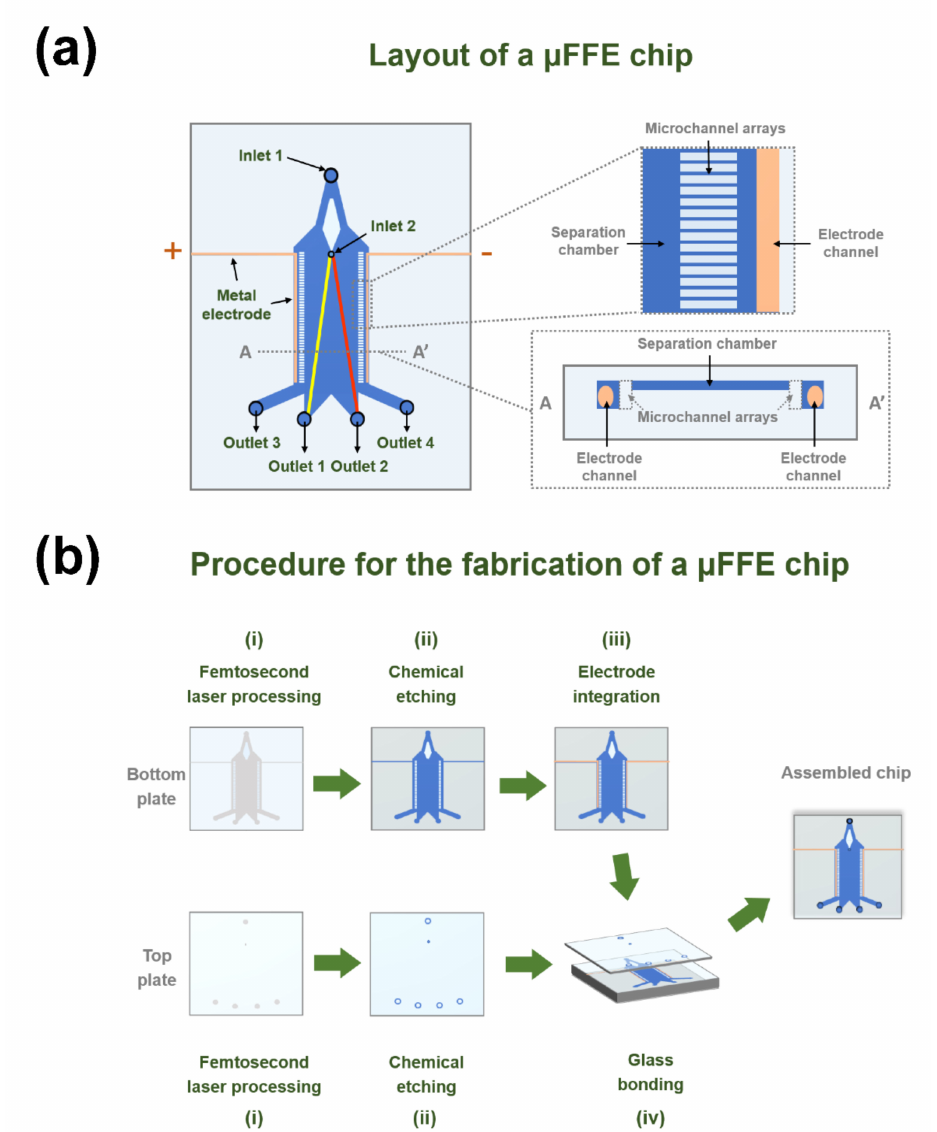
Figure 1. ( a ) Layout of an assembled µ FFE chip. The chip consists of a separation chamber, two electrode channels, two microchannel arrays, two embedded metallic platinum electrodes, two inlets (inlet 1 for buffer solution and inlet 2 for sample solution), and four outlets (outlet 1 and outlet 2 for liquid-phase separation, outlet 3 and outlet 4 for exhaust of bubbles). ( b ) Schematic of the fabrication procedure for microscale free-flow electrophoresis ( µ FFE) chips based on femtosecond laser microfabrication. (i) Femtosecond laser processing of two fused silica plates, including the top and bottom plates. (ii) Chemical etching of the glass plates. (iii) Electrode integration in the bottom plate. (iv) Bonding of the plates for assembling the